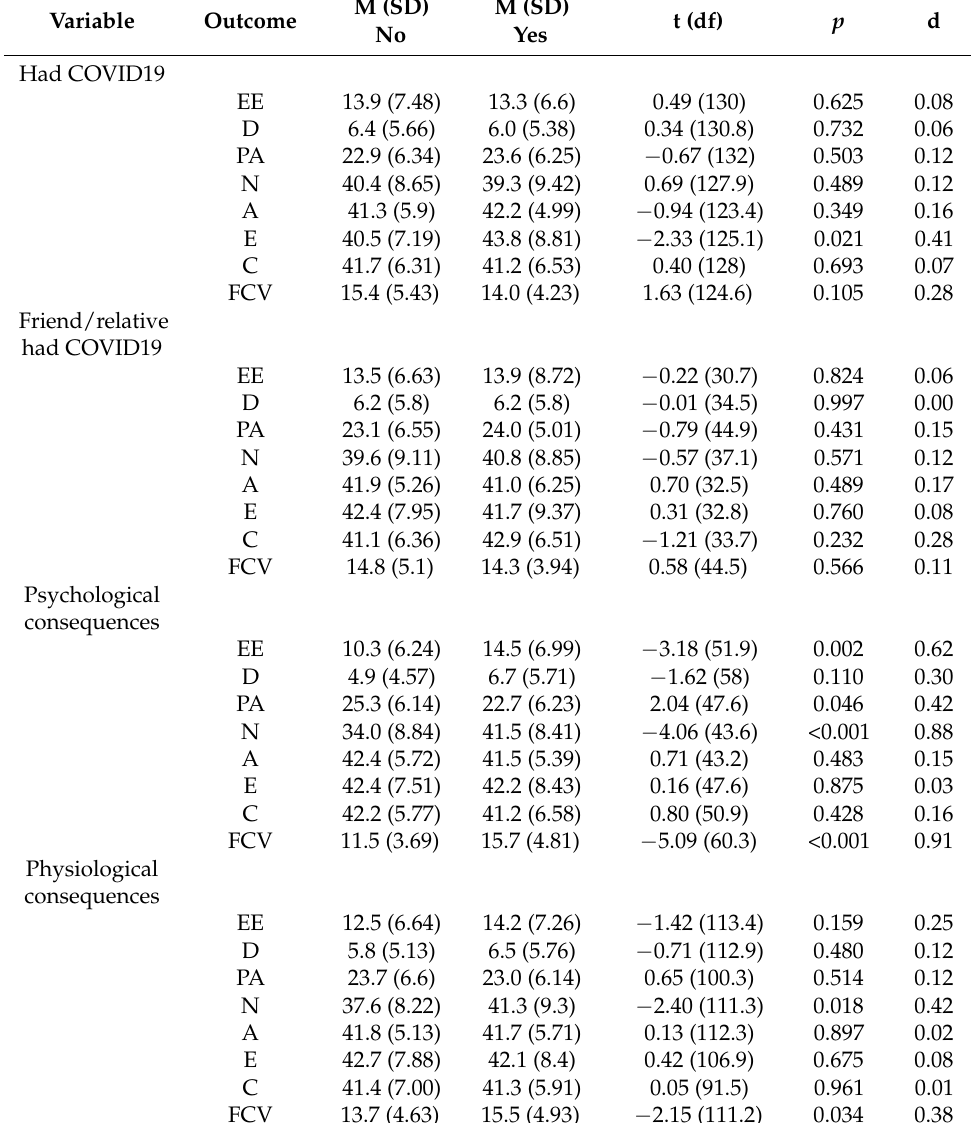
Table 4. Hypothesis tests to analyze differences in burnout according to the coronavirus-related variables.